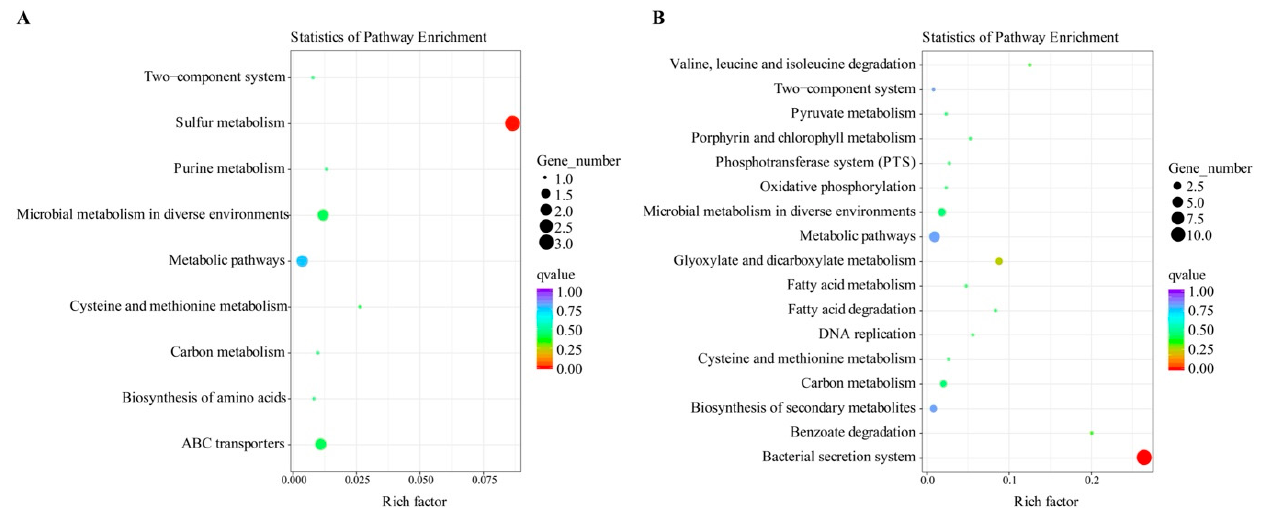
Figure 9. KEGG pathway enrichment analysis of the upregulated ( A ) and downregulated ( B ) mRNAs.